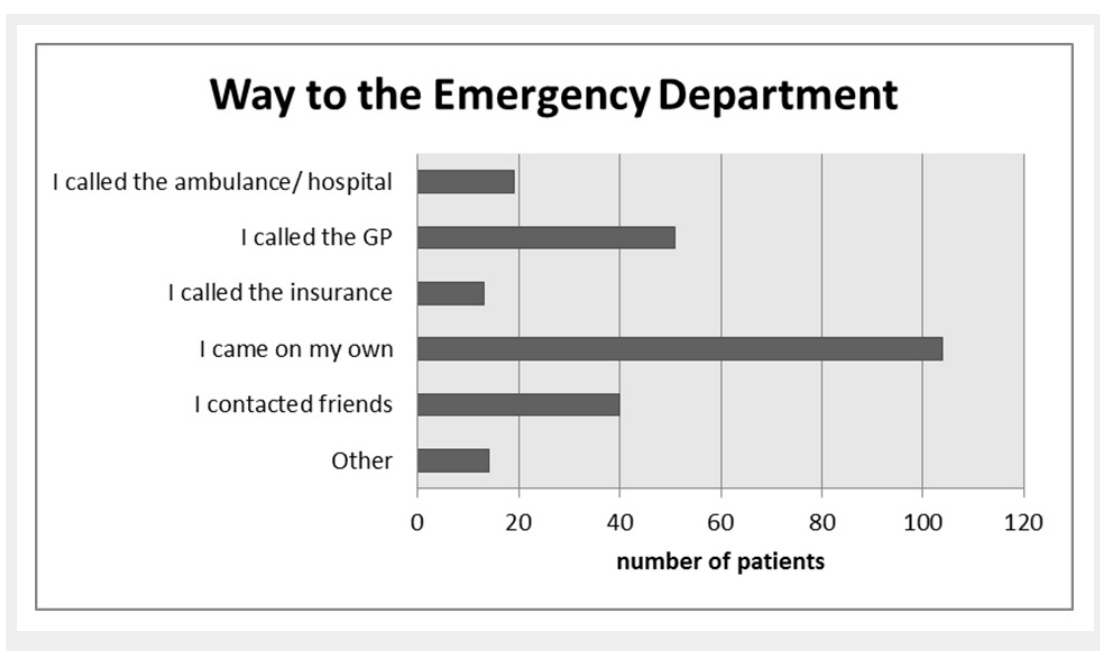
Steps the patient indicated before he decided to come to the emergency department?